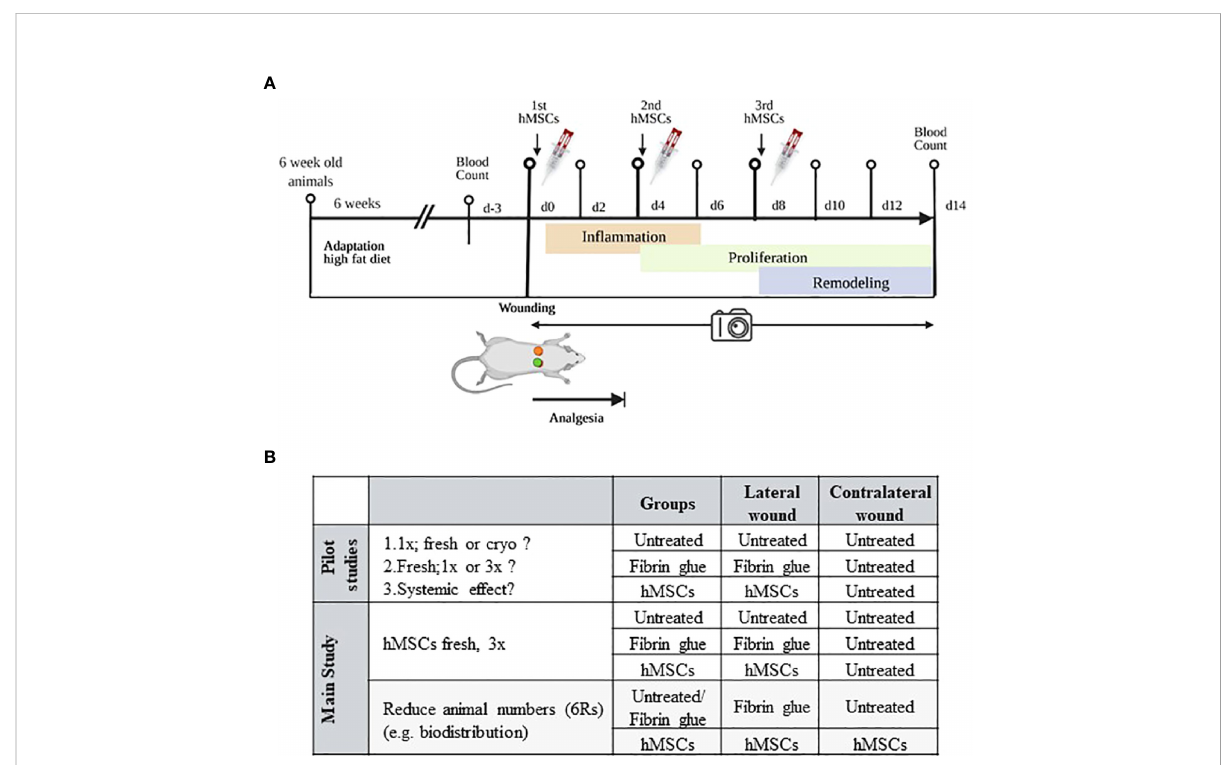
FIGURE 2 Schematic of in vivo wound healing assay. (A) Diabetic ZDF rats were wounded and treated topically with hMSCs (1x10 6 /cm 2 wound) in diluted fi brin glue. Untreated and cell-free fi brin glue-treated wounds served as control (created with BioRender.com). (B) Table representing animal allocation. fresh, MSCs from max. 2 days of rescue-culture before administration to the wounds; cryo, MSCs thawed immediately before application; 1x, single application day 0; 3x, repeated application d0, day 4 and day